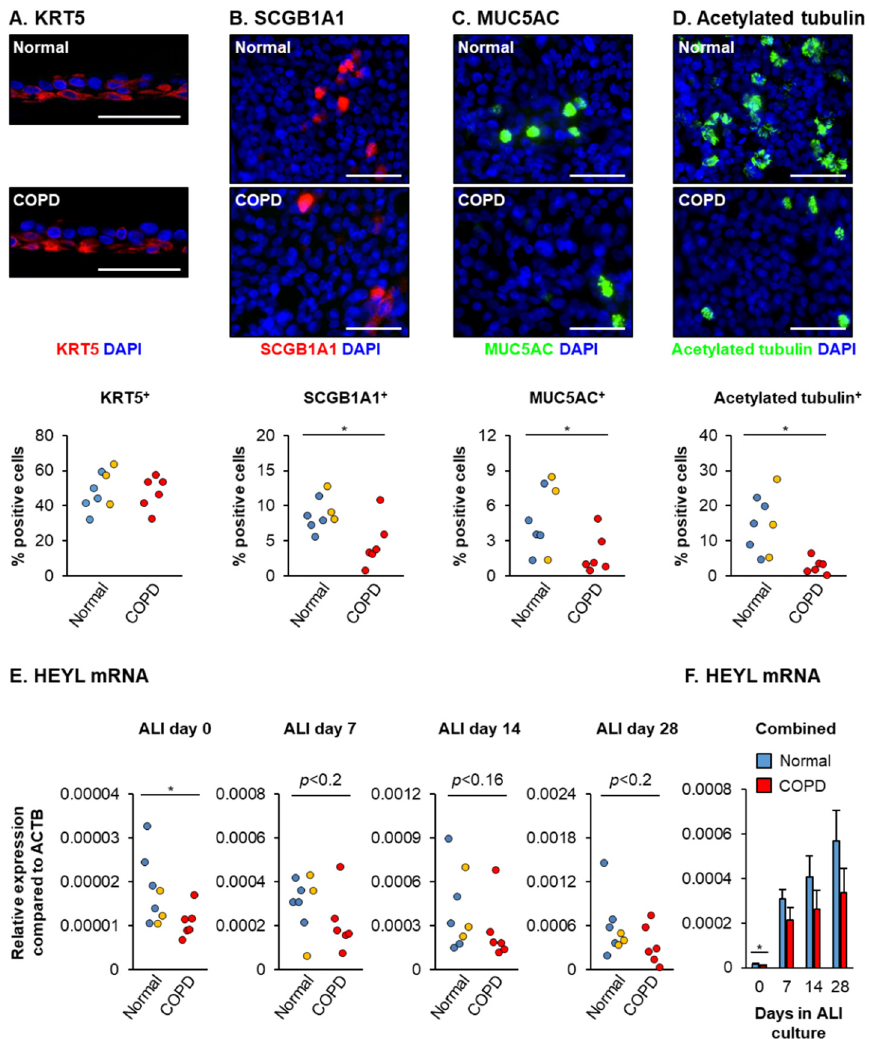
Figure 6. Decreased expression of HEYL is associated with the impaired differentiation capacity of COPD HBECs. Normal ( n = 5 nonsmoker donors (blue circles) and n = 3 smoker donors (orange circles)) and COPD ( n = 6 donors (red circles)) HBECs were cultured on ALI for 28 days to differentiate into a mucociliary epithelium containing basal, club, goblet and ciliated cells. ( A – D ) Immunofluores- cent staining and quantification of basal (KRT5, red), club (SCGB1A1, red), goblet (MUC5AC, green) and ciliated cells (acetylated tubulin, green). Nuclei are stained blue with DAPI. For each donor, the data are presented as percentage of positive cells for each cell type. Scale bar = 50 µ m. ( E , F ) qPCR analysis of HEYL expression as a function of time during ALI culture (days 0, 7, 14 and 28). ( E ) Data presented for individual HBEC donors at each time point. ( F ) Data presented as mean expression for normal ( n = 8) and COPD ( n = 6) HBEC donors at each time point. Error bars indicate SEM. * p < 0.05. Nonsignificant p -values also